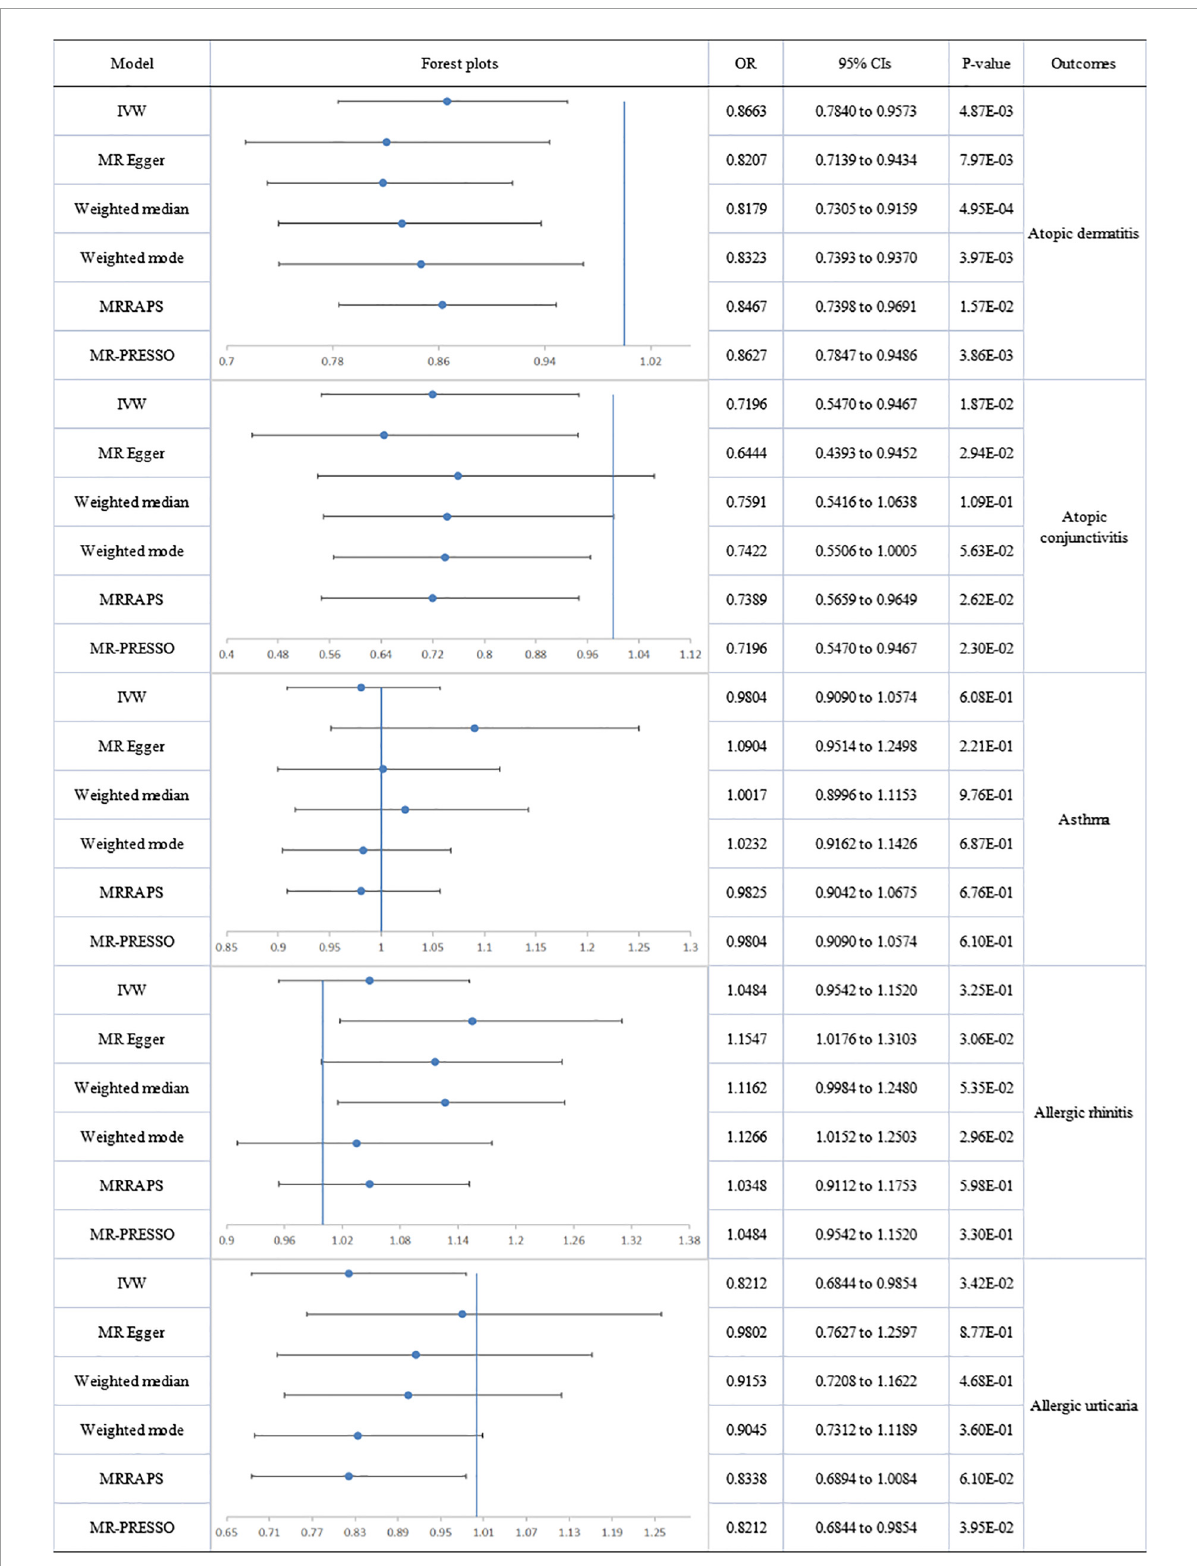
FIGURE2 The forest plot of univariable Mendelian randomization analyses exploring associations between omega-3 fatty acids and risk of allergic diseases using different Mendelian randomization statistical models OR: odds ratio; CIs: confidence intervals.